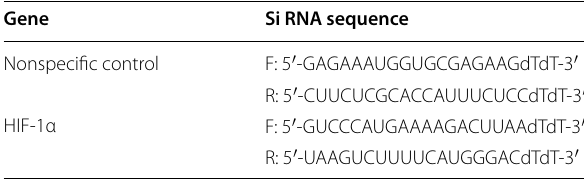
Table 2 siRNA target sequences Gene Si RNA sequence Nonspecific